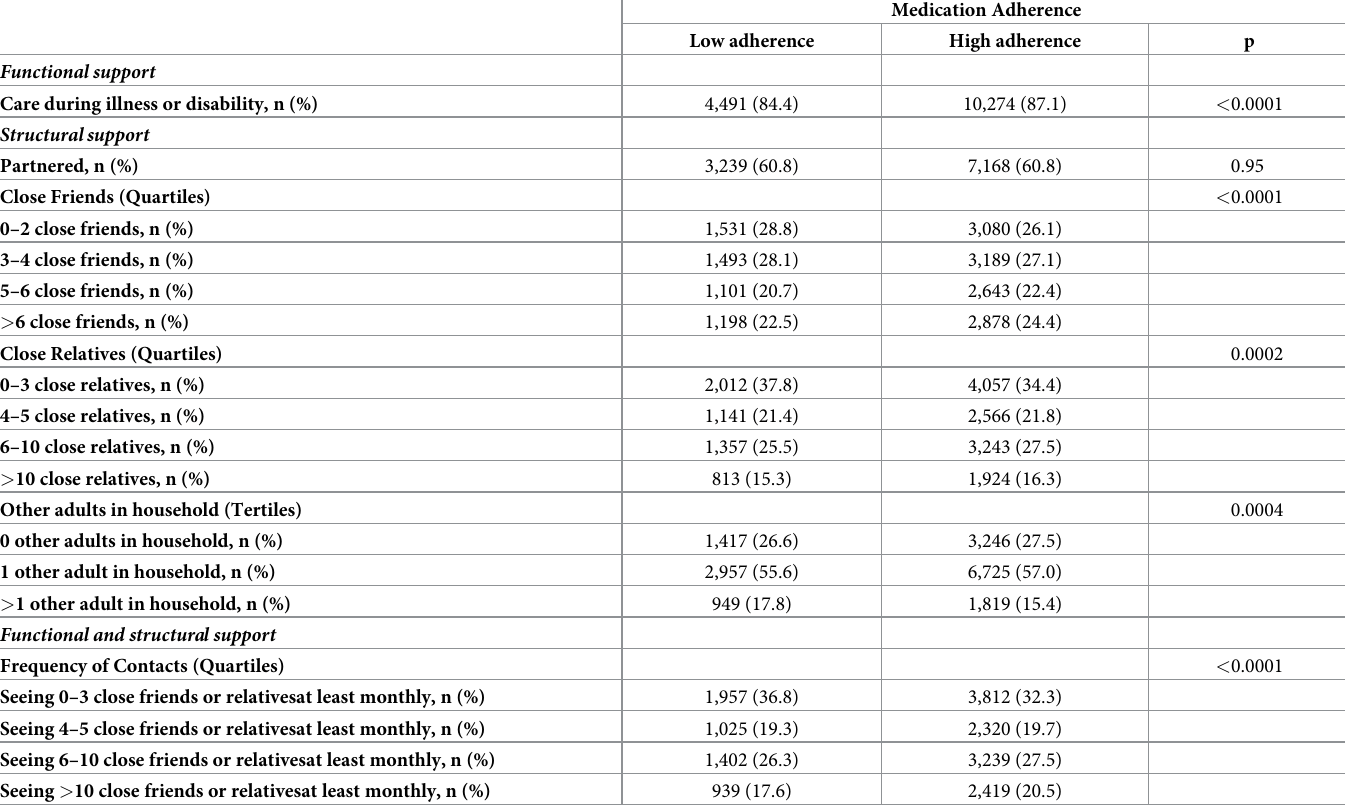
Table 2. Social support components by medication adherence